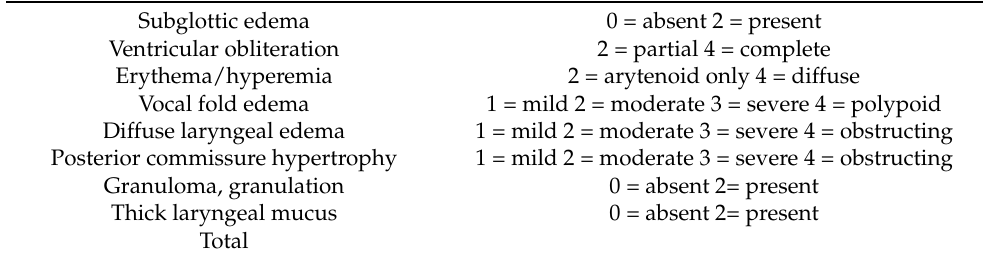
Table 2. Reflux finding score.